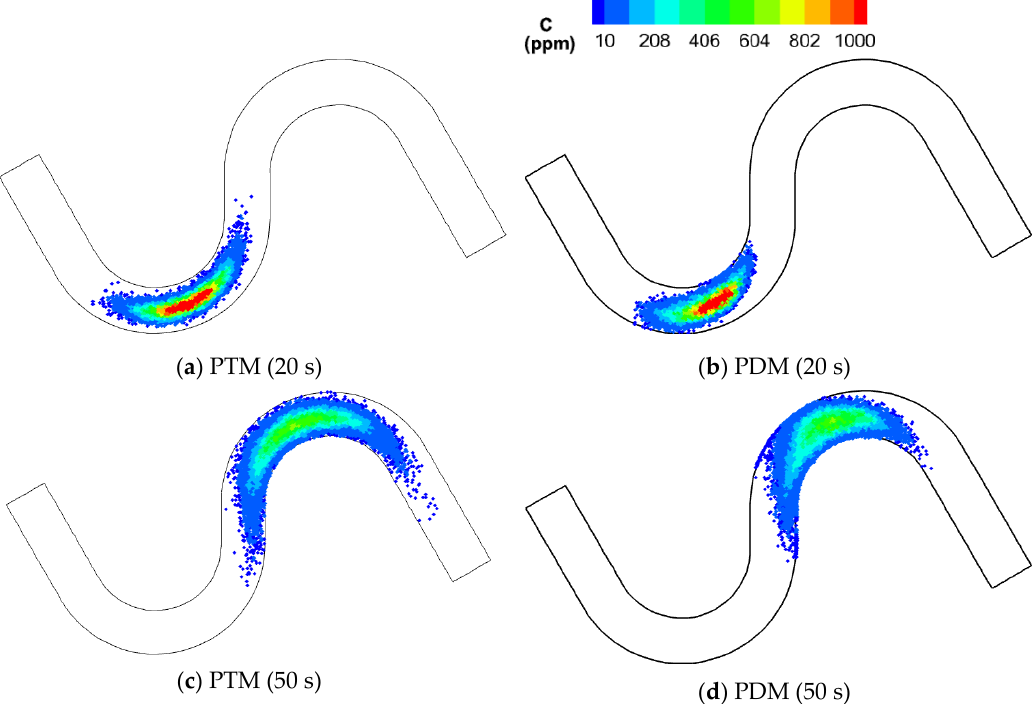
Figure 7. Particle transport simulation results using the two types of particle tracking models (C306).